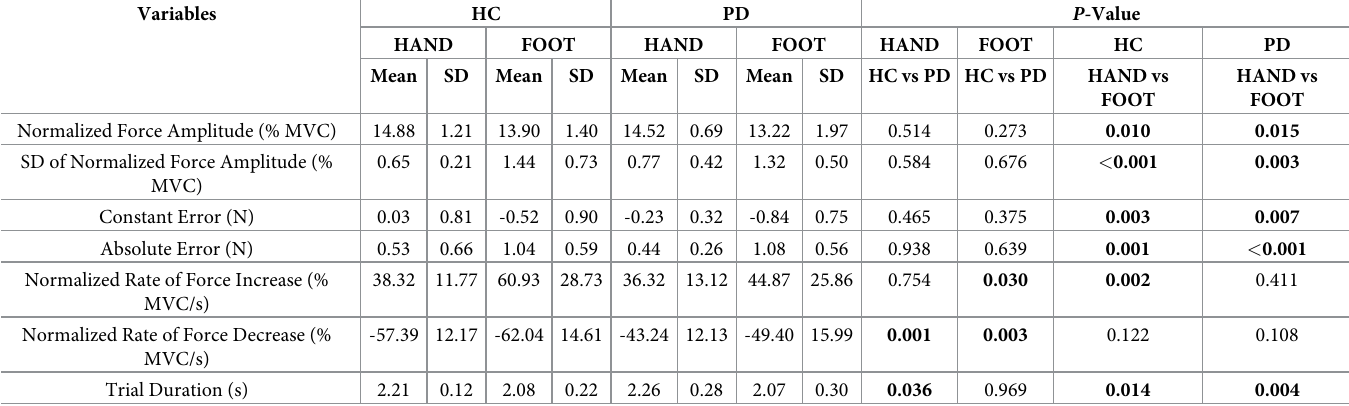
The table the force outcome measures derived from the hand and foot force production tasks. Data are presented for each group and limb in the form of means ± 1 standard deviation (SD). The p -values corresponding to the statistical analyses described statistical analyses described in the “Statistical Analysis” section are also included. Values highlighted in bold indicate statistically significant results at p < 0.05. Abbreviations: HC = healthy controls; MVC = maximum voluntary contraction; N = Newtons; PD = Parkinson’s disease; s =